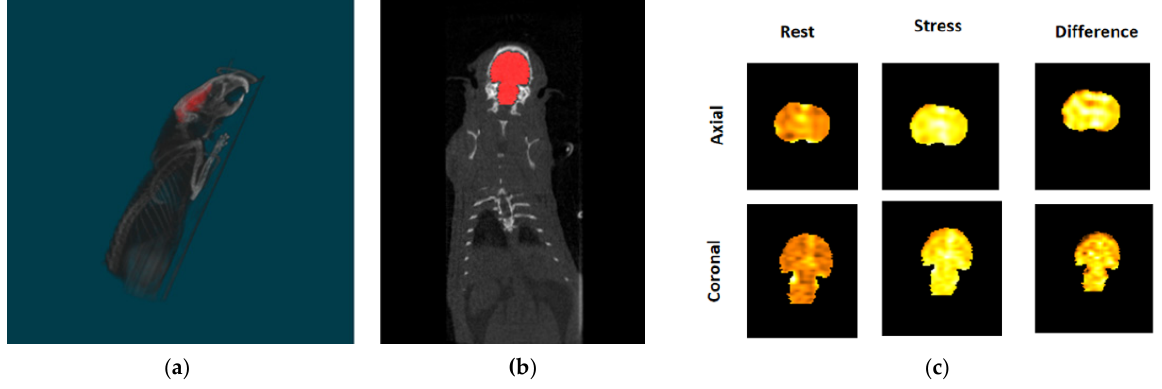
Figure 1. Sagittal ( a ) and coronal ( b ) PET/CT images of a representative rat brain segmentation. ( c ) FDG RBC tracer activity in the segmented rat brain under rest and pharmacological vasodilatory (“stress”) conditions, as well as the difference between the two after digital subtraction imaging (“Difference”). Total rats = 6.